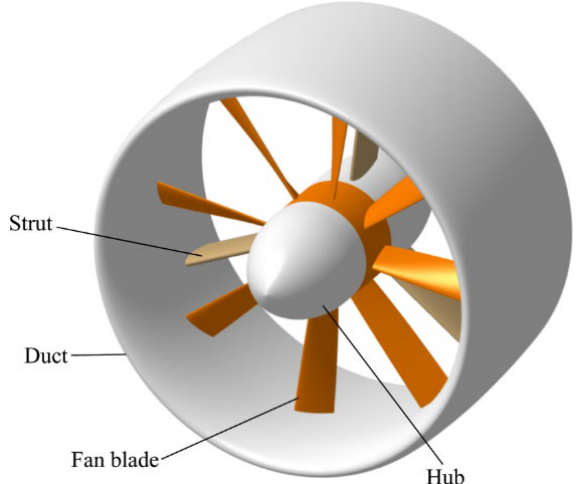
Figure 1. Ducted fan model.